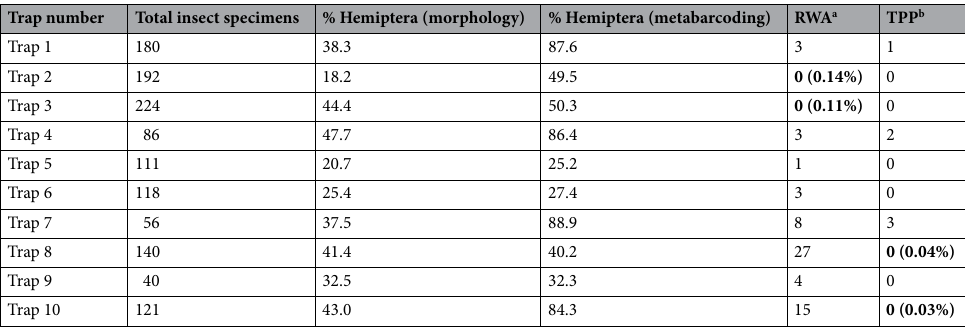
Table 2. Number of specimens from field survey traps used for metabarcoding analyses, with a comparison of the percentage identified as Hemiptera by morphology and metabarcoding. The metabarcoding identification is based on sequencing reads from all three loci. Bold highlighting indicates traps where metabarcoding unexpectedly detected pest species, with the proportion of sequencing reads attributed to RWA or TPP in brackets. a Russian wheat aphid (RWA) specimens from field surveys. b Tomato potato psyllid (TPP) added from ethanol-preserved specimens from Western